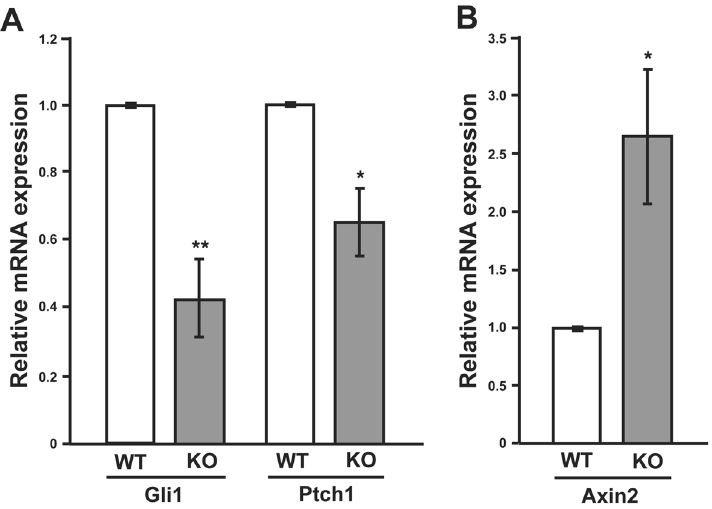
Figure 7. Altered ciliary signaling in the Cby1-KO pancreas. Real-time PCR analysis was performed for expression levels of the direct Hh target genes Gli1 and Ptch1 ( A ) and canonical Wnt target gene Axin 2 ( B ) in the adult pancreas (n = 3 per genotype). WT values were set as 1. Data represent means ± SEM. *p < 0.05; **p <